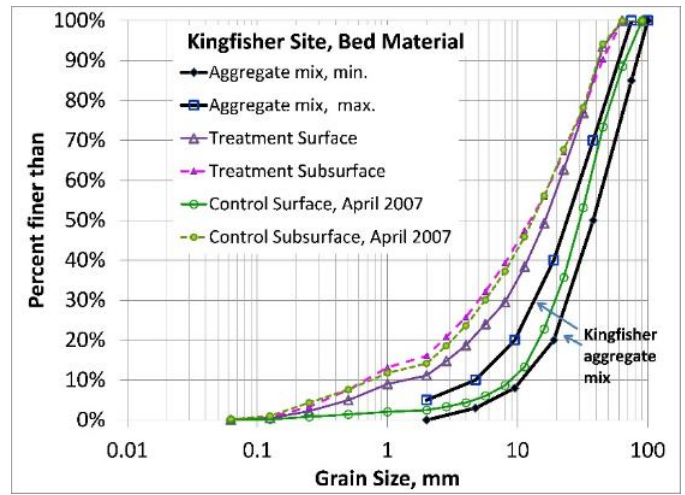
Figure 5. Design aggregate gravel size distribution relative to pre-project streambed gravel sizes.